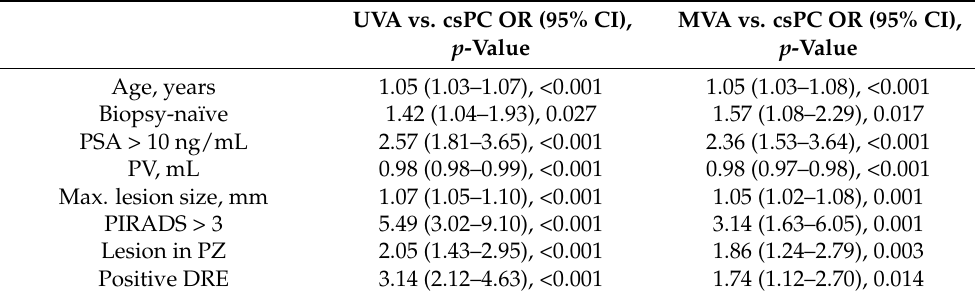
Table 2. Association between clinically significant prostate cancer (csPC) diagnosis and other fac- tors, DRE included.